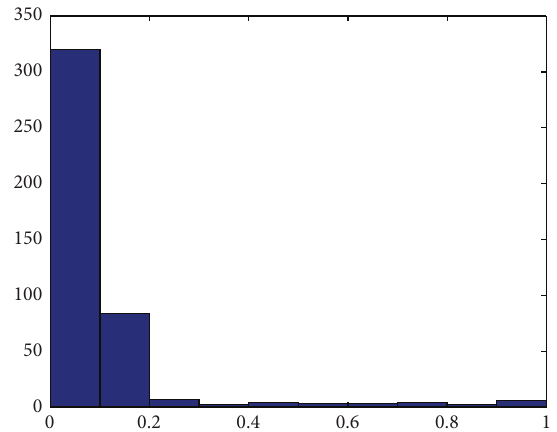
Figure 5: Histogram of the absolute off-diagonal entries of 𝐺 based on the original sensing matrix.